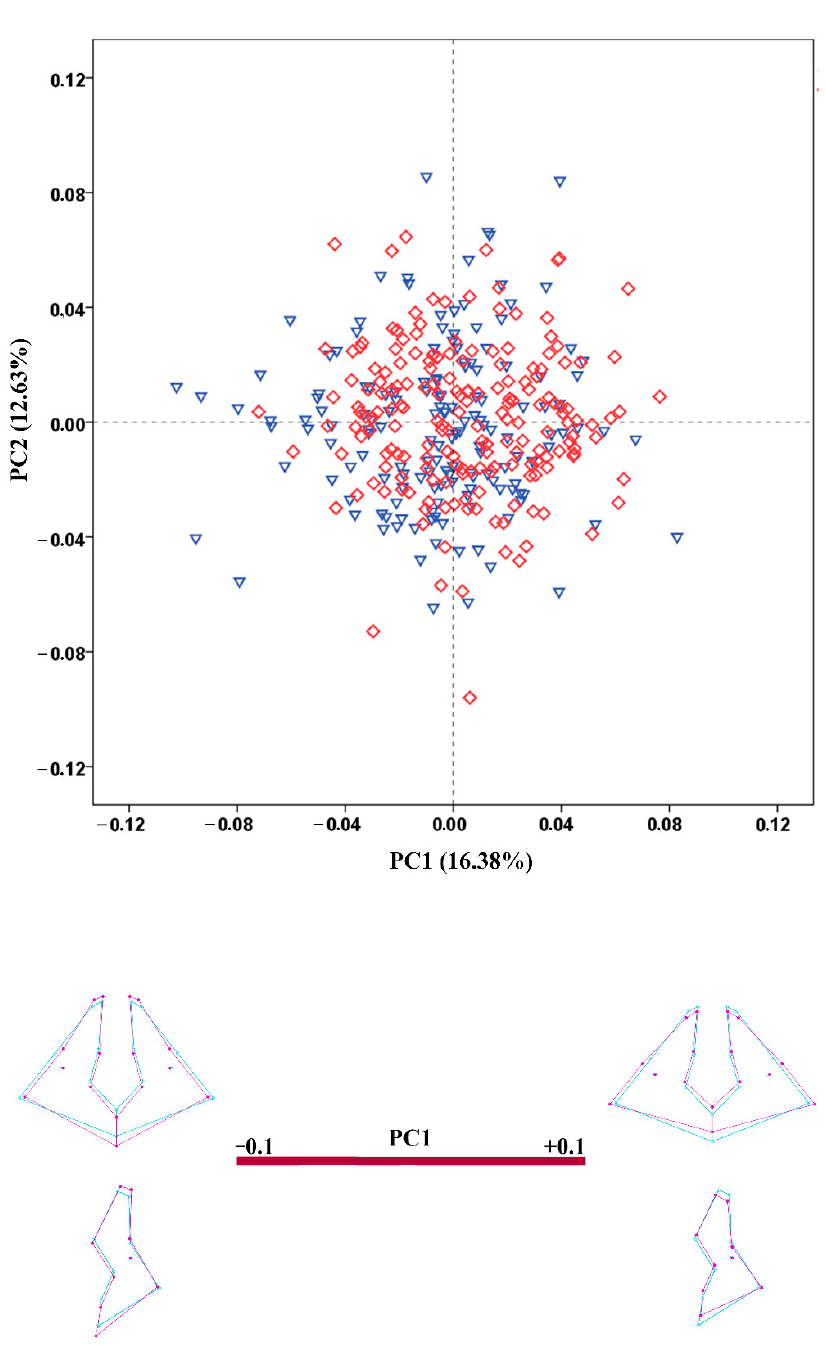
Figure 6. PCA scatterplot for the configuration of the maxillary region. The wireframes illustrate the shape variation along the axis of PC1. Male crania—blue triangles; female crania—red rhombs; extreme shape configurations—purple wireframes; mean shape configuration—light blue wireframe.